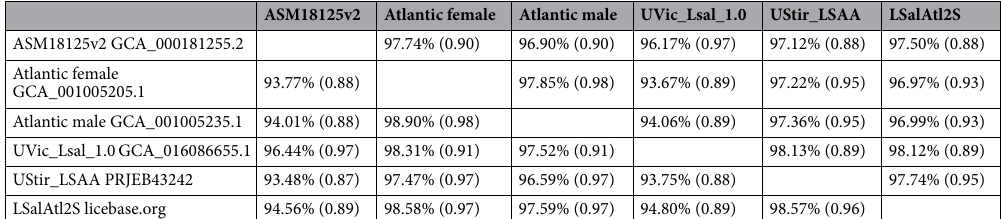
Table 2. Consistency of assemblies. The assemblies were converted to 240 bp synthetic reads that were blasted against all other assemblies. The assemblies from which synthetic reads originated are indicated in column headings and the reference assemblies are indicated in the row headings. The results show average query cover % and (the proportion of reads that maps with > 95% identity).